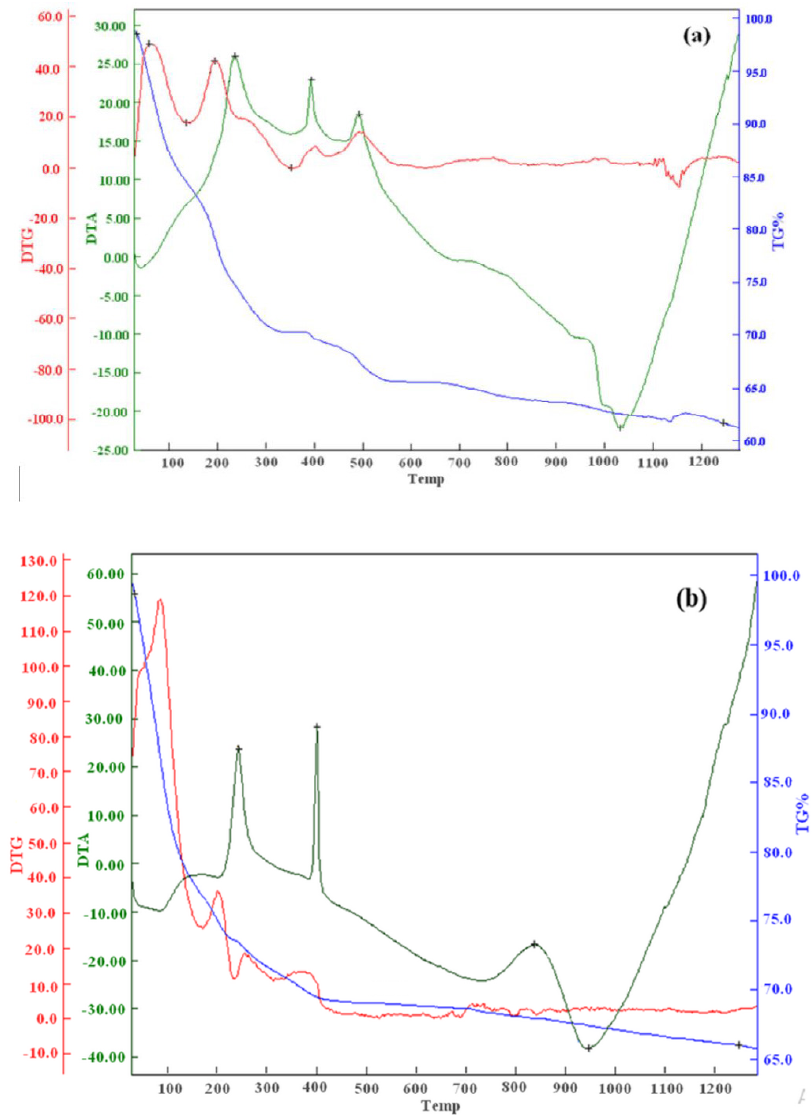
Fig. 2. Thermal behavior of precursors: (a) Cu-TiO Figure 2. Thermal behavior of precursors: (a) Cu-TiO 2 and (b) Pc-Cu-TiO 2 H-NC